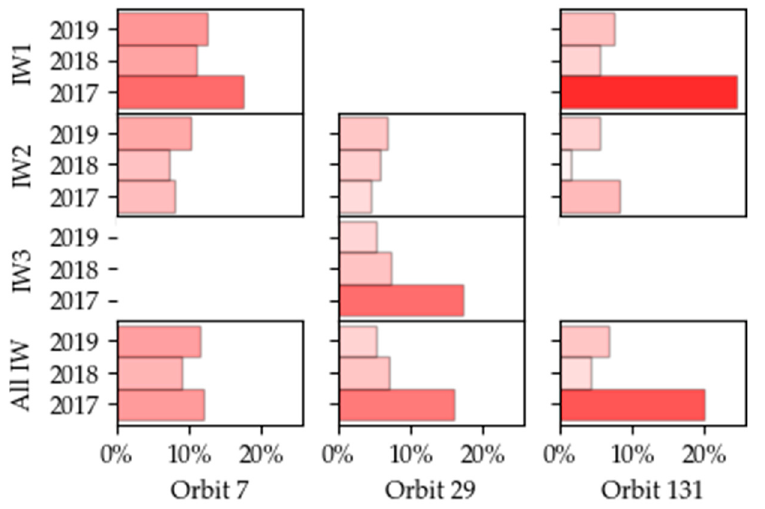
Figure 6. Percentage of forest pixels misclassified as urban, disaggregated by orbits and sub-swathes, at the temperate site.